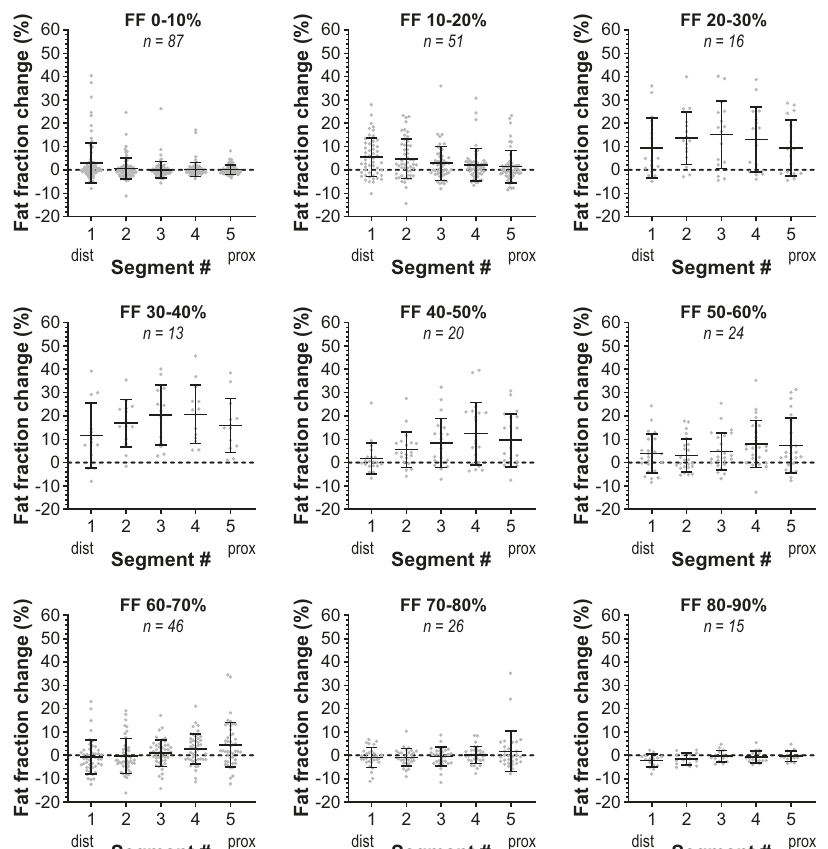
Fig. 5 Wave-like progression of fat in fi ltration along the proximo-distal muscle axis in facioscapulohumeral muscular dystrophy (FSHD) patients. Each panel represents muscles with a 10% incremental range of baseline fat fraction (FF) values. At a baseline fat fraction <10%, only a marginal change in the average fat fraction is seen for the fi rst most distal segment. At a baseline fat fraction of 10 – 20%, the average fat fraction increases in the distal segments (segments 1 and 2). At a baseline fat fraction of 20 – 40%, the average fat fraction increases in all segments, but most in the middle three segments (segments 2, 3, and 4). At a baseline fat fraction of 40 – 80%, the average fat fraction increases, especially in the proximal segments (segments 4 and 5), but the increase is lower than that for fat fraction between 20 – 40% and steadily diminishes at a higher baseline fat fraction. n is the number of included muscles. Data were presented as mean ± SD and individual data points were displayed as grey dots. Fat fraction changes normalised to residual muscle mass are displayed in the supplemental note.